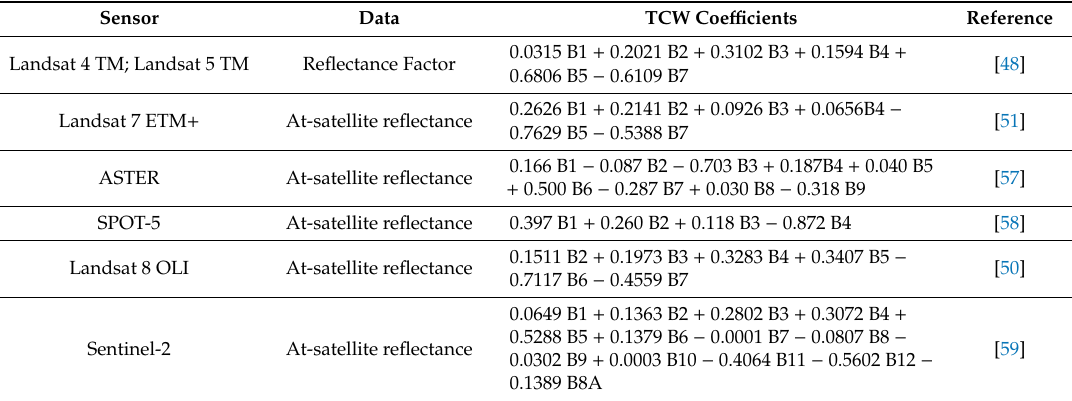
Table 3. Examples of Tasseled Cap Wetness (TCW) coe ffi cients for di ff erent optical satellite